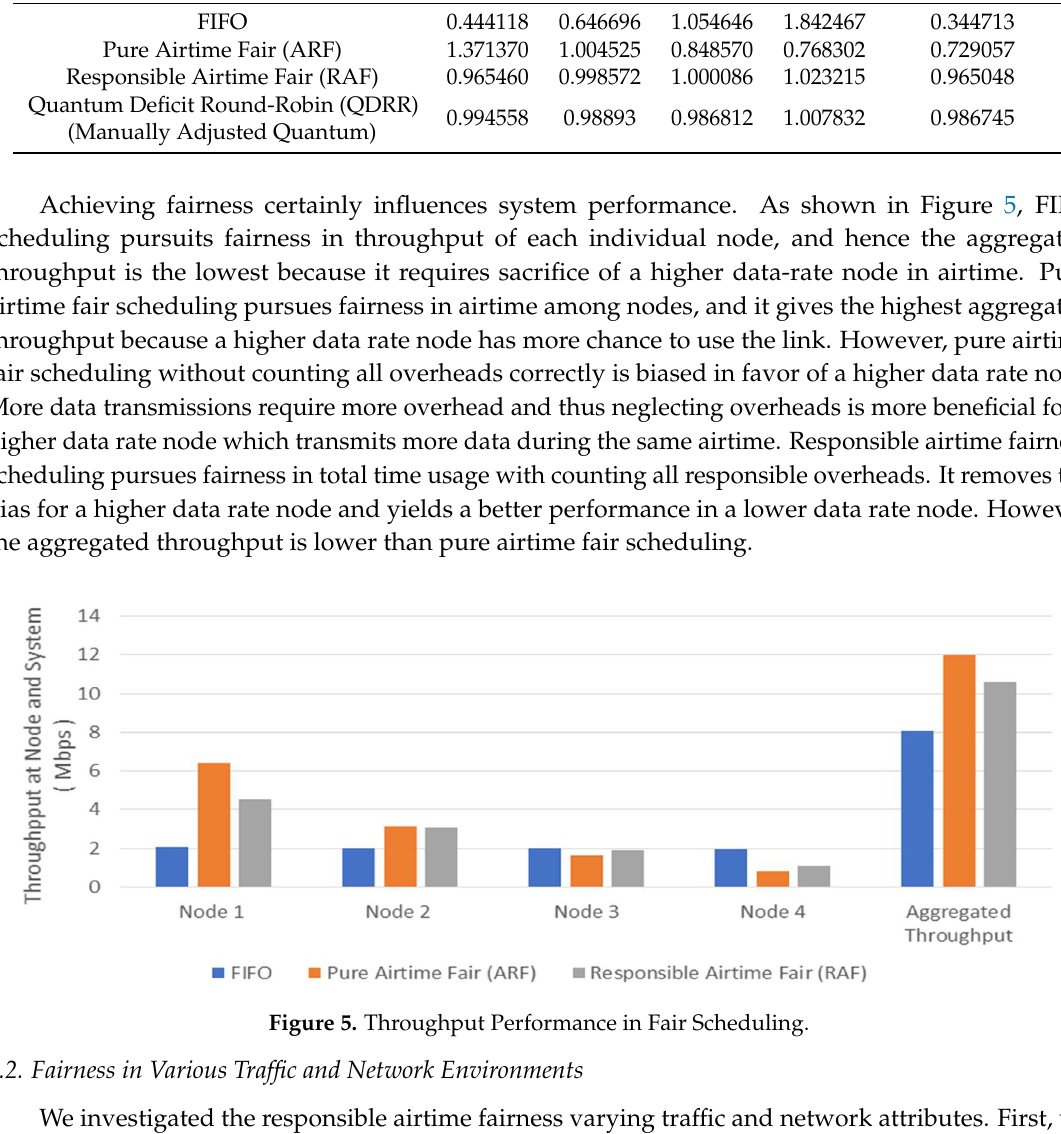
Table 5. Throughput Achieving Ratio and Fairness Index in UDP Traffic.